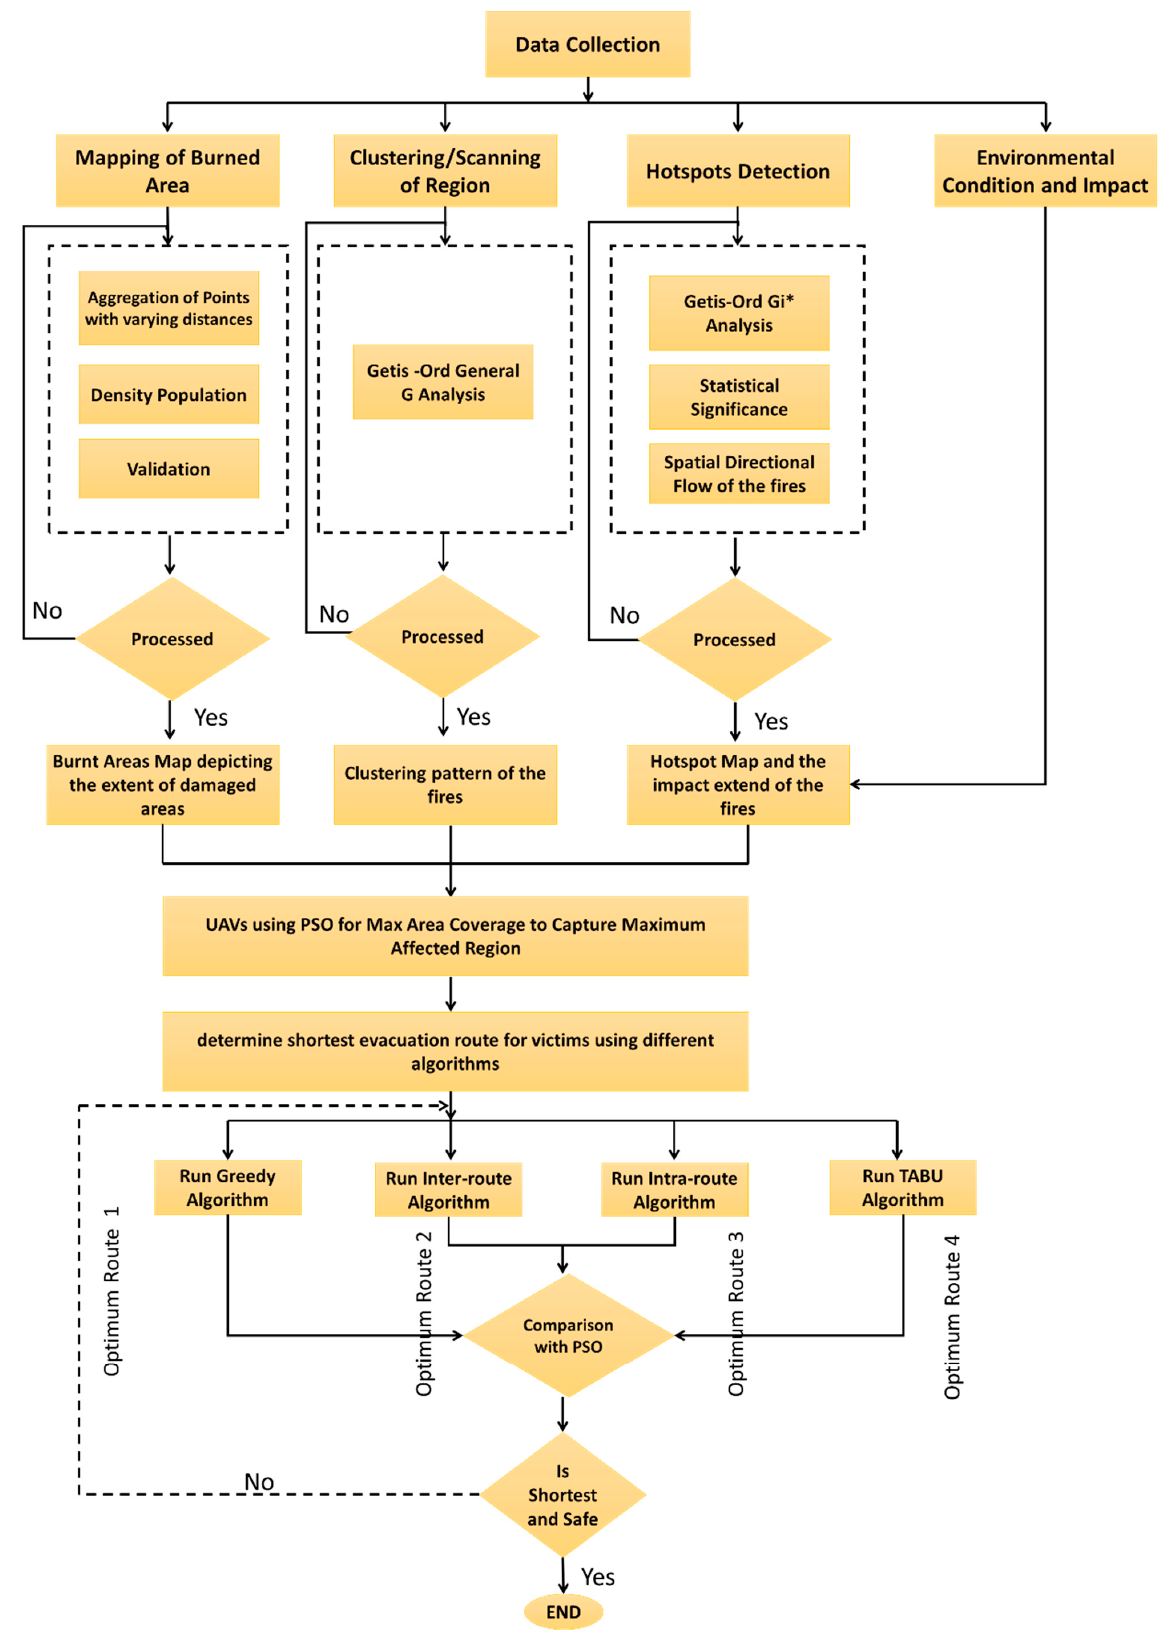
Figure 2. Method flowchart of the current study.